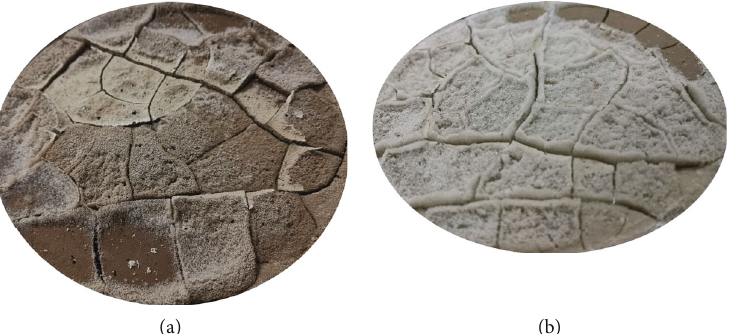
Figure 13: Flocculent layer of grains on the surface of the soil sample. Images of sample: (a) with 1.6% detergent at 85h and (b) with 3.2% detergent at